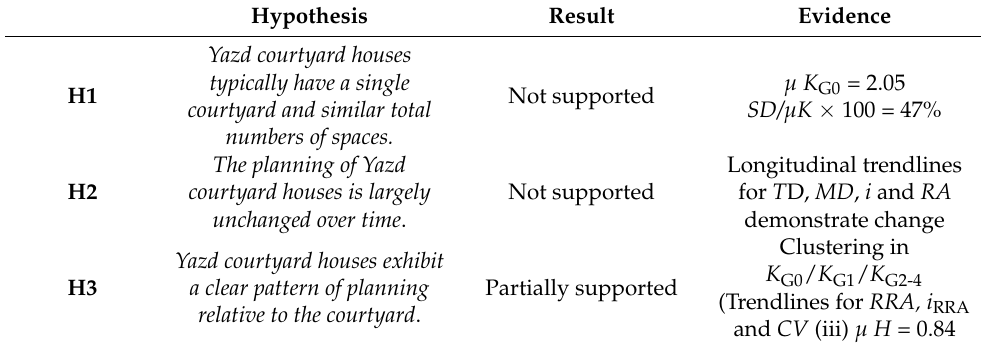
Table 6. Summary of